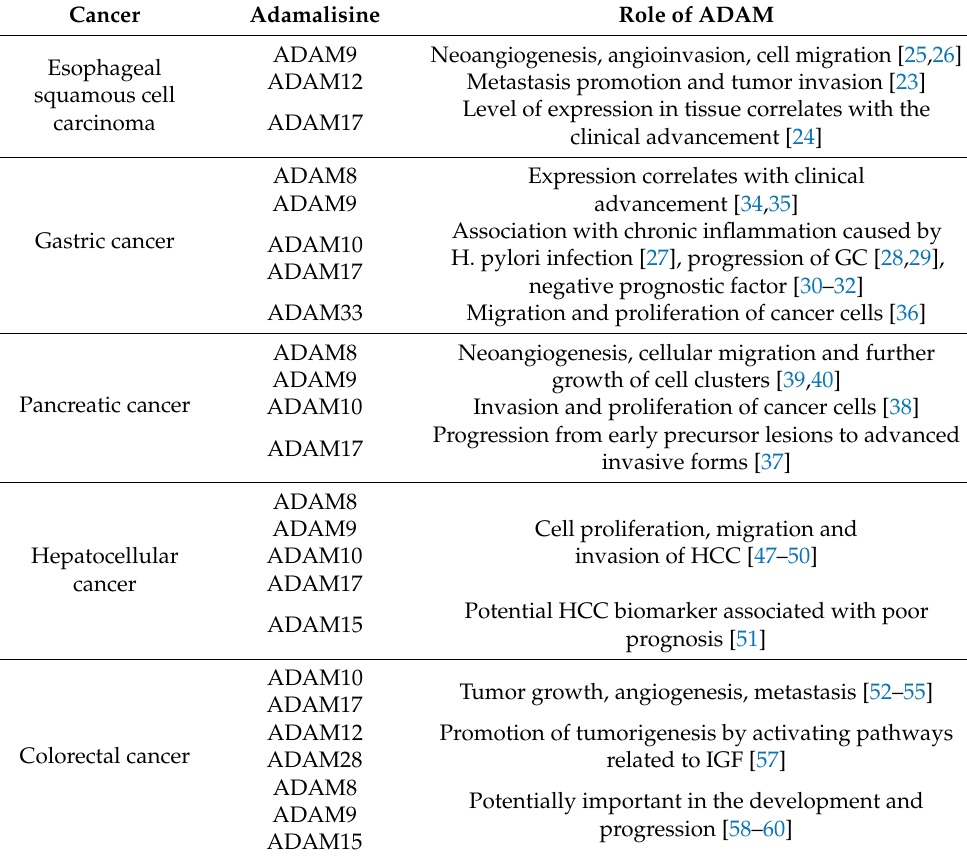
Table 1. The role of adamalysines in GI cancers. Own